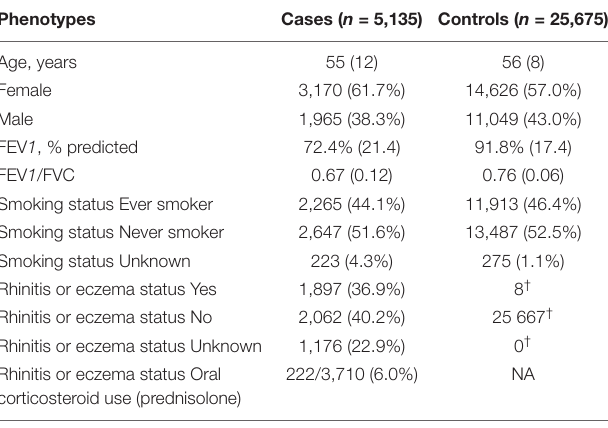
TABLE 2 | Baseline characteristics of asthma cases and controls (Shrine et al.,